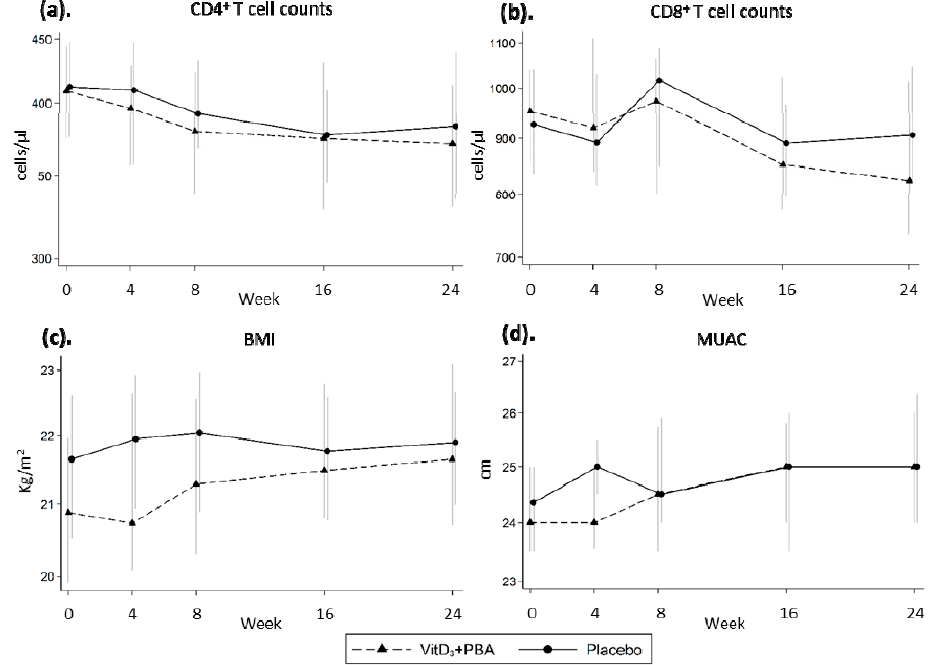
Figure 3. Secondary analyses. Peripheral CD4 + and CD8 + T cell counts, BMI, and MUAC were assessed at baseline and at weeks 4, 8, 16, and 24 after initiation of vitD 3 + PBA supplementation. ( a ) CD4 + T cell counts, ( b ) CD8 + T cell counts, ( c ) BMI, ( d ) MUAC. Crude data from the mITT cohort are presented as the median and 95% CI. In a – d , the solid line represents placebo while the dotted line represents vitD 3 + PBA treatment. BMI, Body Mass Index; MUAC, Mid-Upper-Arm